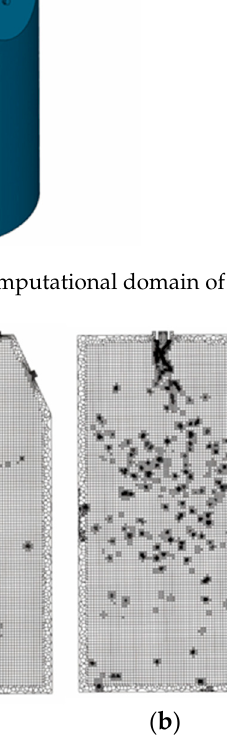
Figure 5. Adaptive hexcore mesh refinement. ( a ) Plane XOZ. ( b ) Plane YOZ.